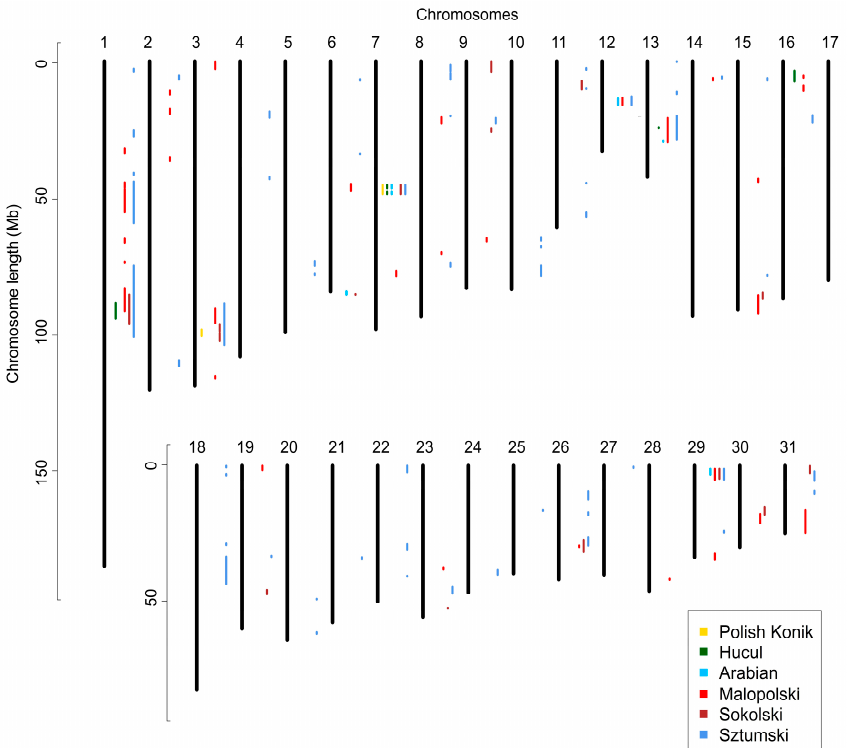
Figure 5. Regions of no ROH presence detected in the analyzed breeds. In the identified no-ROH regions we observed 36 to 431 genes, with the highest num- ber of genes detected for SZTUM (431), MLP (236), SOK (148), HC (82), AR (43), and KP (36), respectively. A relatively high number of genes were common for multiple breeds. We observed 27 genes that were identified in five breeds, 9 in four breeds, and multiple variations of genes in three (from 1 to 25) and two (from 3 to 67) of the breeds. The genes for up to three breeds are presented in Table 2, with more detail in Supplementary Table S8. Table 2. Genes detected in regions of no ROH presence in multiple breeds. Up to three breeds are shown. Breeds